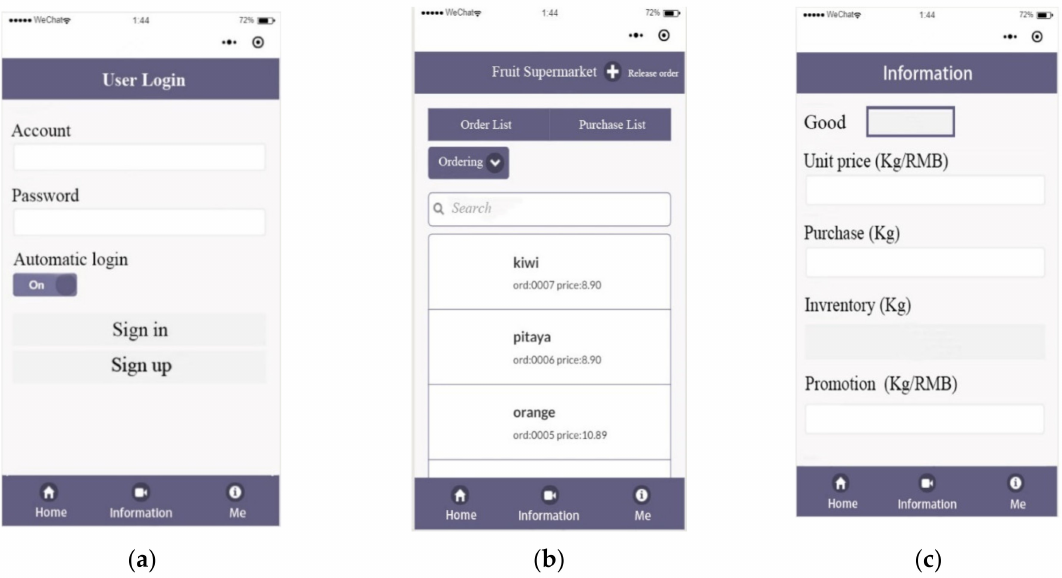
Figure 16. The design interfaces of mini-program. ( a ) Login interface. The username and password interact with the server by submitting a form. Only after the server-side verification is successful can the order information page of the applet be accessed; ( b ) order interface; ( c ) setting